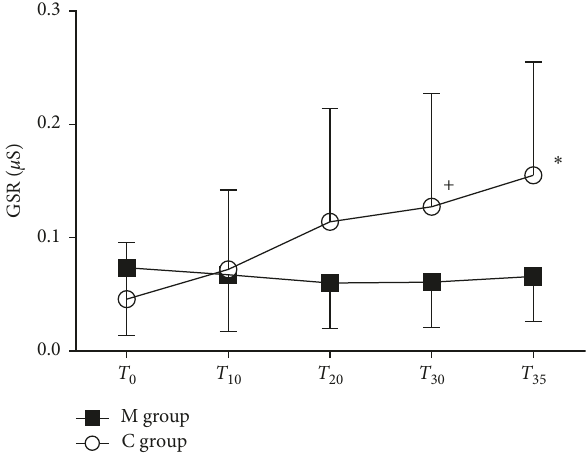
Figure 5: Galvanic skin response. Galvanic skin response ( µ S) in the music group (M group) and control group (C group) at dif- ferent time point. Data are presented as mean 0 .